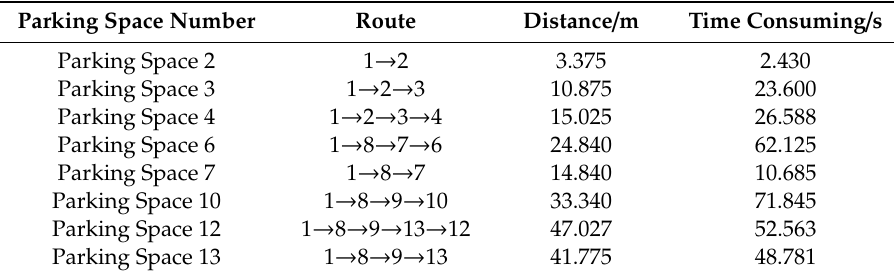
Table 2. Initial driving route of each parking